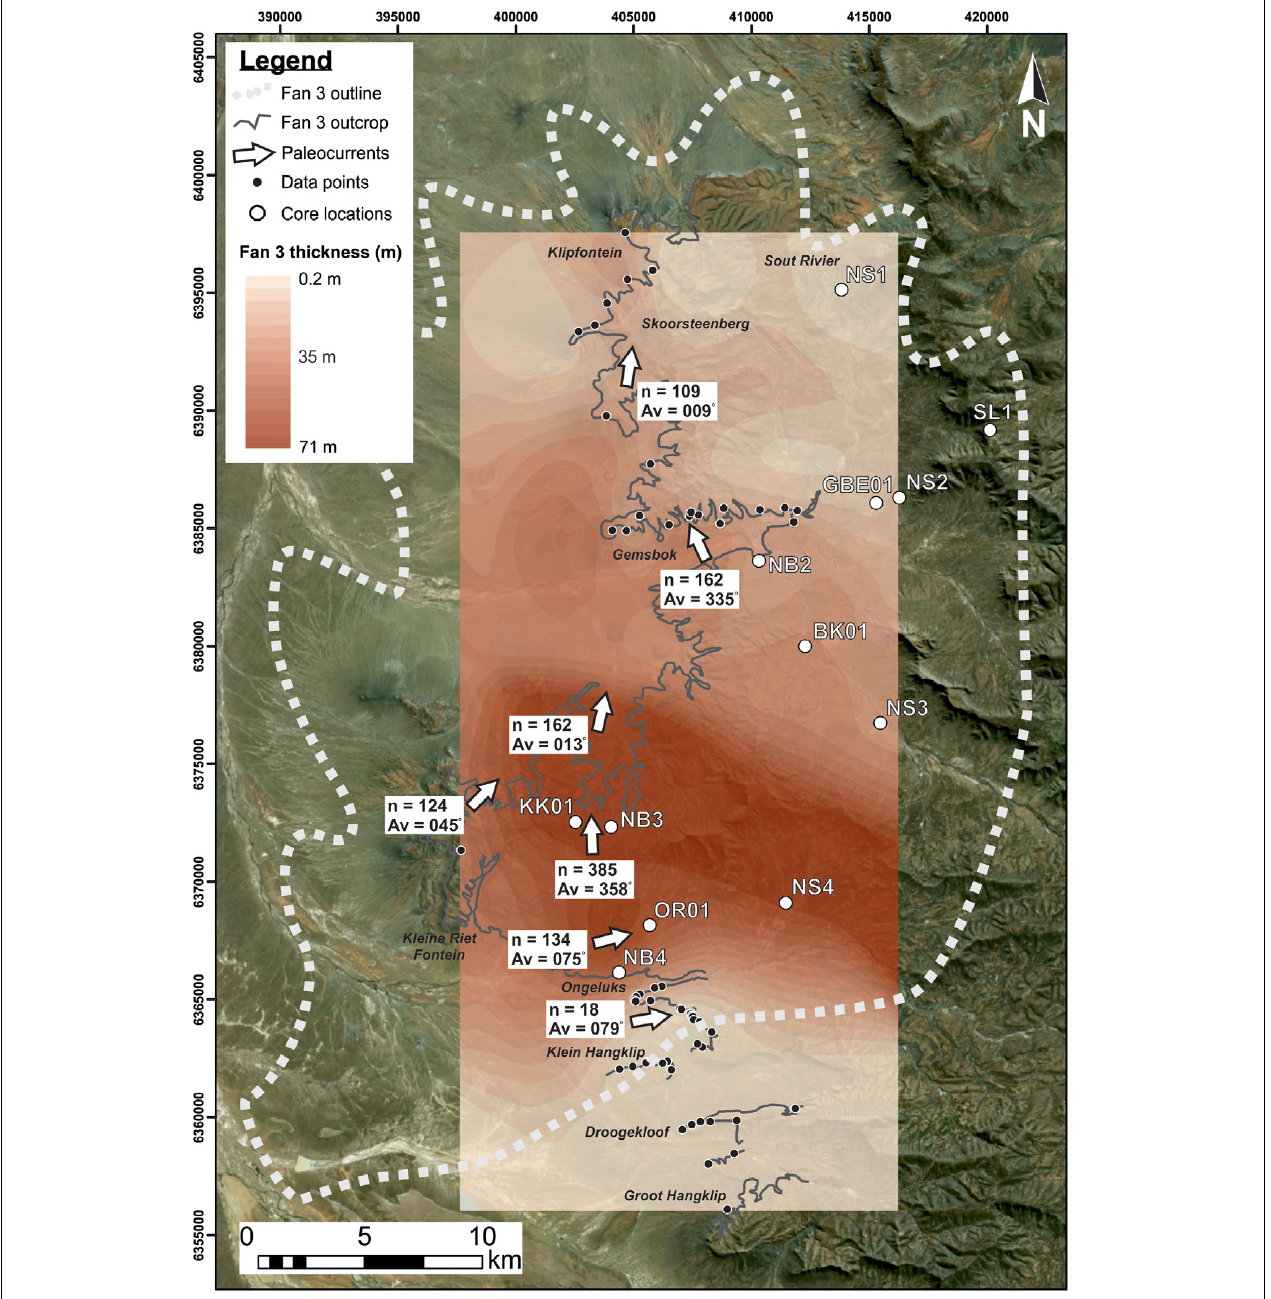
FIGURE 5 | Isopach thickness map of Fan 3 constrained from integration of core and outcrop data taken from this and previous studies (Hodgson et al., 2006; Prélat et al., 2009; Spychala et al., 2017b). Note the rapid thinning in the southern area compared to the rest of the isopach map. Average paleocurrent measurements are also indicated by the white